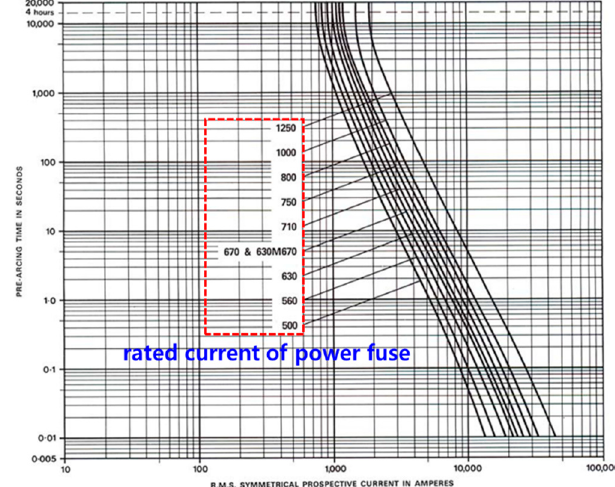
Figure 3. TCC curve of DC power fuse.